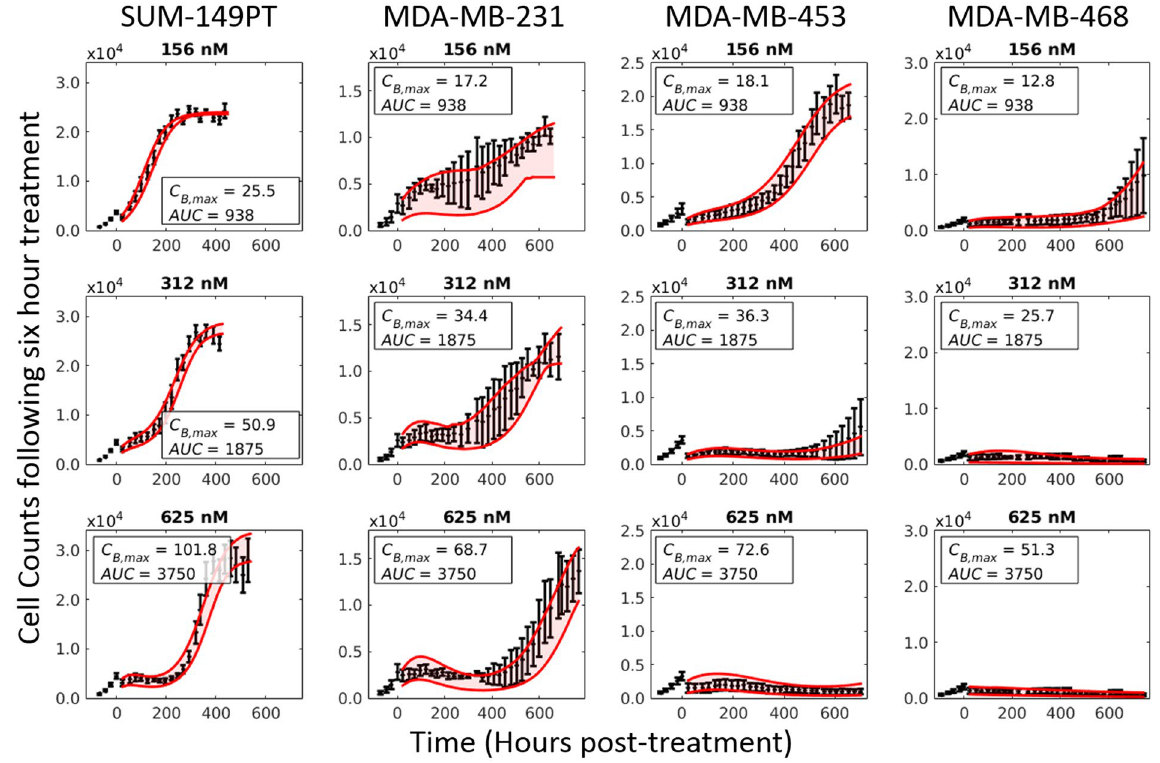
Figure 4. Dose-response curves in a panel of TNBC cell lines. Each cell line was plated and serially imaged via fluorescence microscopy for 30 days following a 6-hour doxorubicin treatment. Nuclear counts from these images are displayed below in black with error bars representing the 95% CI from the six experimental replicates. Each column corresponds to an individual cell line, and each row corresponds to a doxorubicin concentration. These counts are fit to Eqs (4–5) as described Section 2.5. Model fits with 95% CI are superimposed on the cell counts. While there is significant variability in cell line sensitivity to doxorubicin treatment, the dynamics of each cell line follows a similar pattern: following treatment the population growth rate slows as a function of treatment, and depending on the treatment duration and concentration, a rebound in population growth rate is